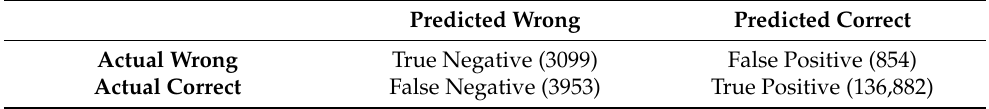
Table 2. Training confusion matrix.